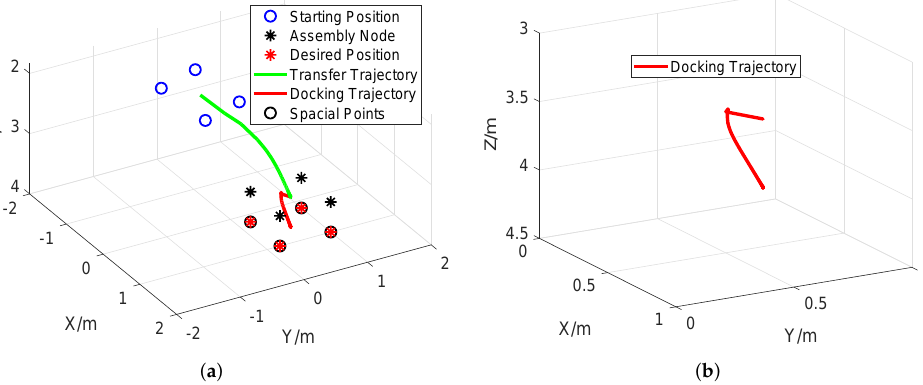
Figure 8. Simulation results by the classical controller: ( a ) Complete Spatial trajectory of the robotic arm. ( b ) Docking trajectory.